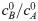
Numerical Simulation: Test of reciprocal relationships from initial conditions obtained with cathodic and anodic mass transfer limited pre-polarizations.A: bulk concentration ratio cB0/cA0 = 2. B) bulk concentration ratio cB0/cA0 is 0.5. The top row of figures shows behavior at open circuit potential from anodic pre-prepolarization conditions (V = +0.5 V). The second row shows behavior at open circuit potential from cathodic pre-polarization (V = -0.5 V). The third row shows the ratio of concentrations obtained by dividing cB(t) from the first row figure by cA(t) from the corresponding second row figure. The bottom row of figures show the currents for initial conditions iA[V = +0.5 V] (bold),iC[V = -0.5 V] (solid) and the scaled sum of the currents (dashed). For the left figure, the scaled sum is iA/2 + iC. For the right figure, the scaled sum is iA + iC/2.